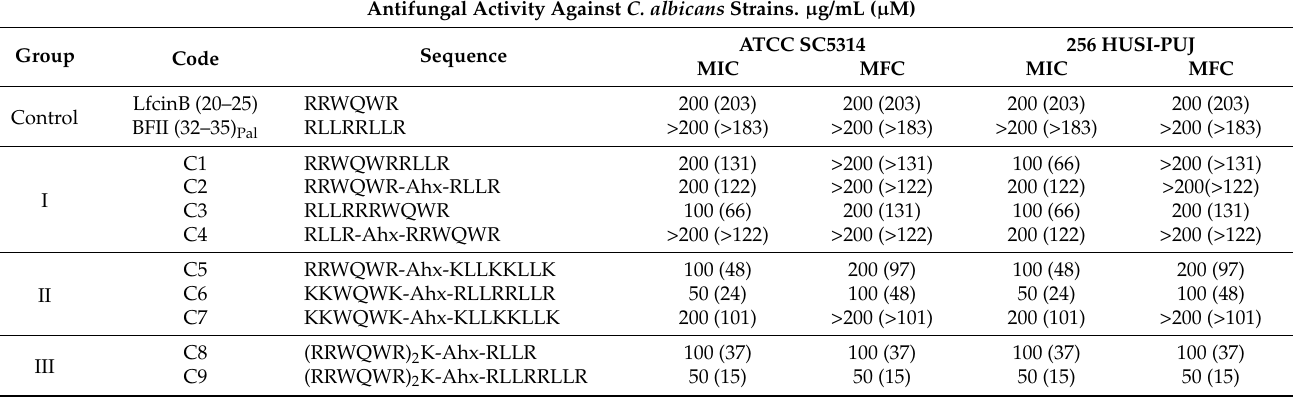
Table 1. MIC and MFC values for each branched chimeric in the two C. albicans strains. Antifungal Activity Against C. albicans Strains. µ g/mL ( µ